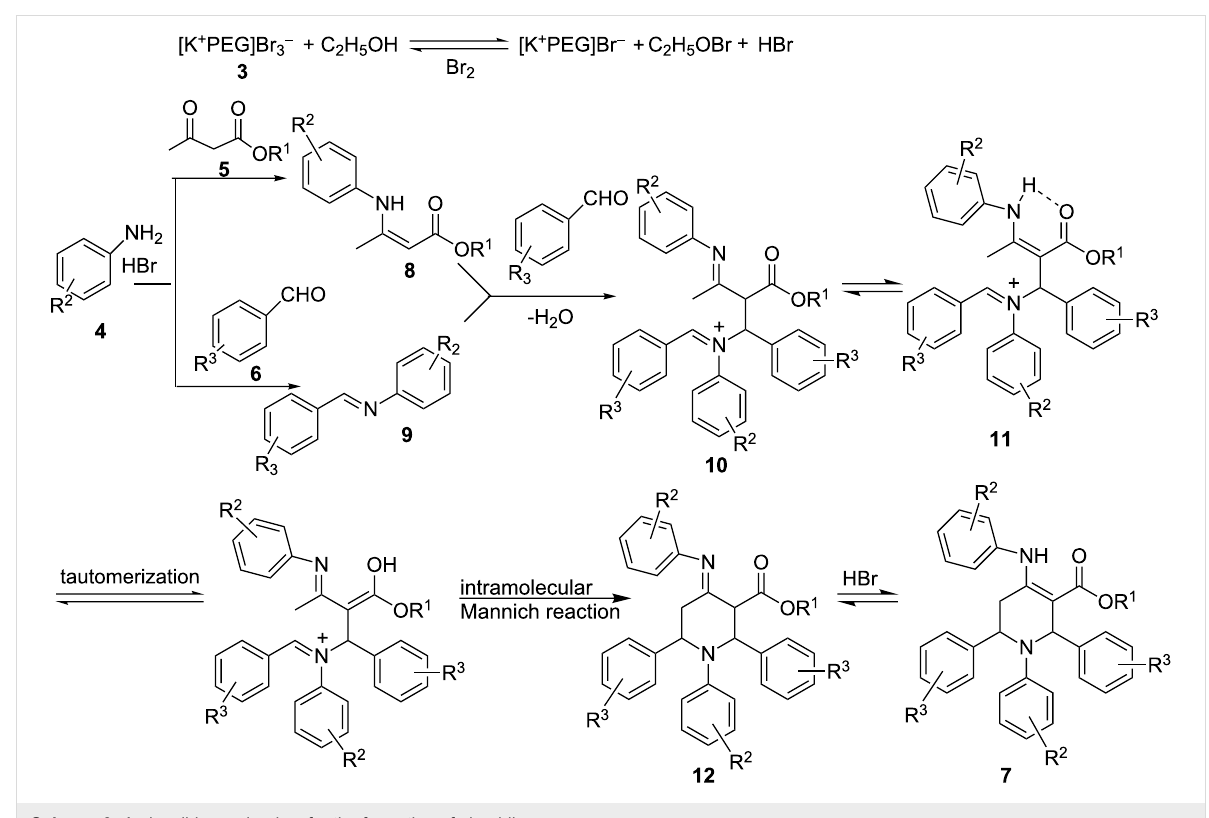
Scheme 3: A plausible mechanism for the formation of piperidines.